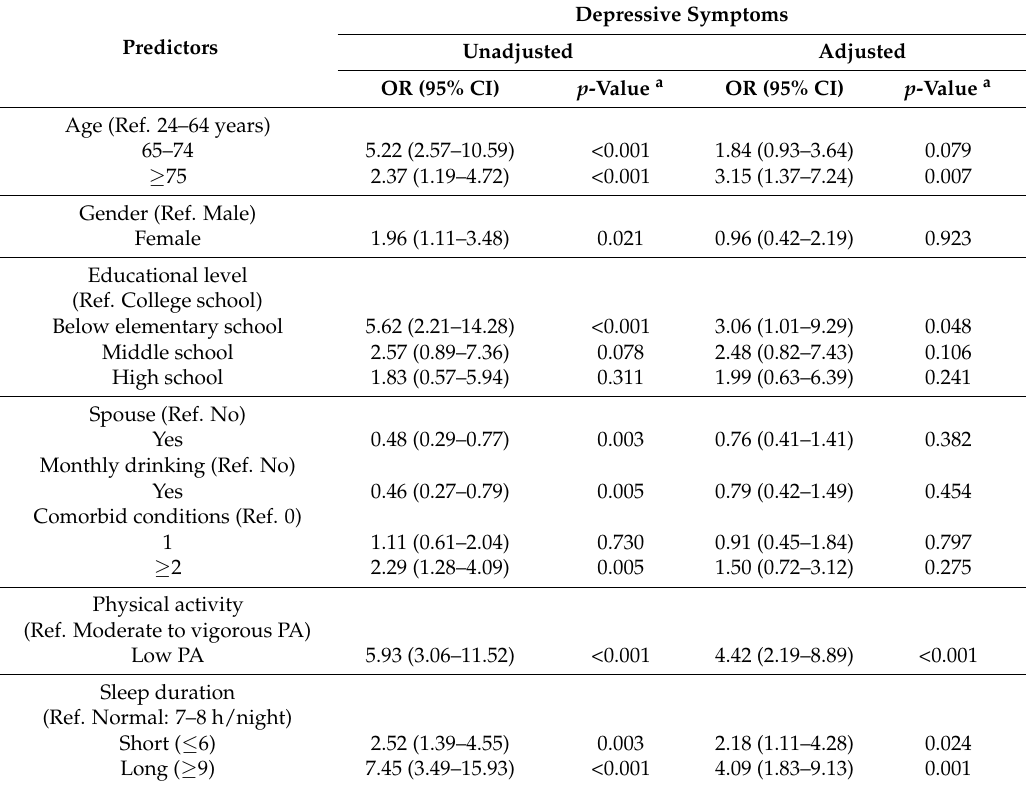
Table 3. Predictors of depressive symptoms in patients with hypertension ( n =